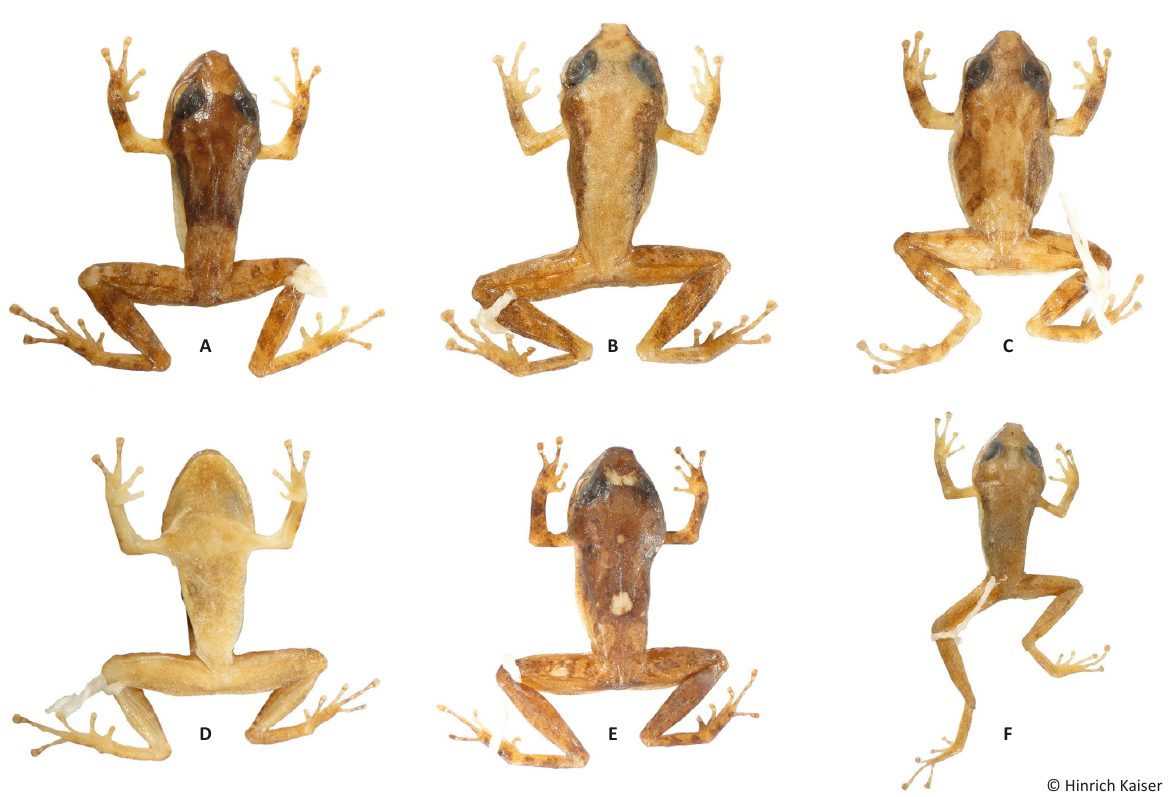
Image 4. Dorsal pattern variation in Pristimantis nubisilva sp. nov., illustrating the shirt-and-trousers phenotype (A; CVULA 7423, male, SVL = 19.3mm), the dorsoconcolor phenotype (B; CVULA 7425, male, SVL = 20.8mm), a combination of shirt-and-trousers and dorsoconcolor pattern (C; CVULA 7427, male, SVL = 19.4mm), a shirt-and-trousers phenotype with a light middorsal blotch (E; CVULA 7424, male, SVL = 18.2mm), and a plain dorsum (F; CVULA 7430, holotype, female, SVL = 24.5mm). The ventral coloration is plain (D;